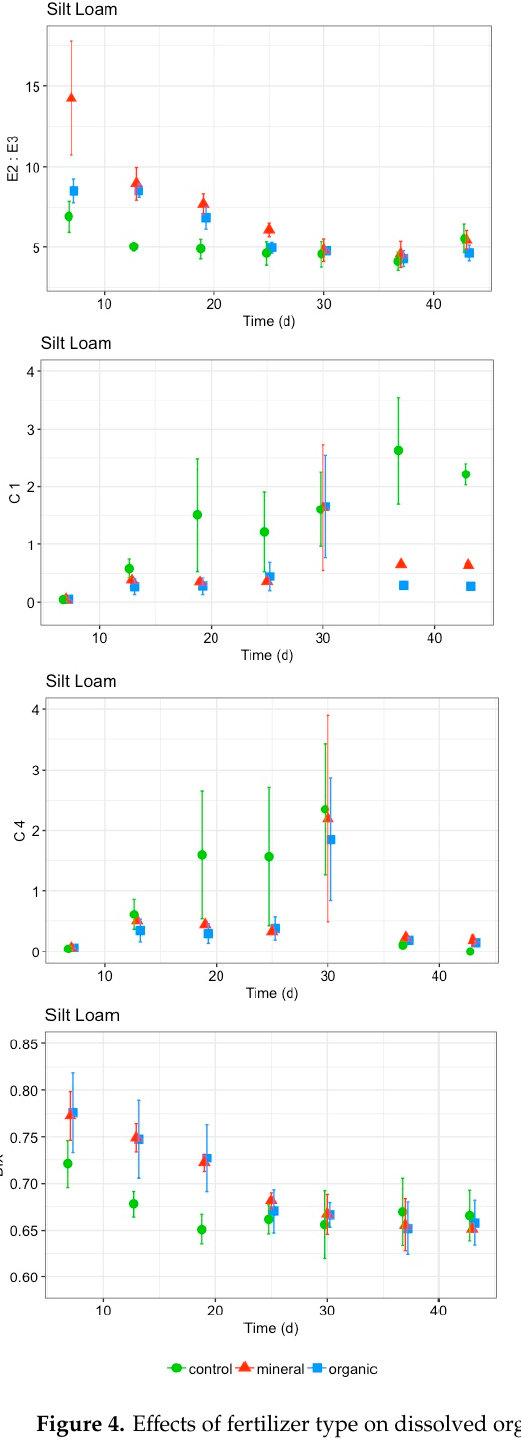
Figure 4. Effects of fertilizer type on dissolved organic matter (DOM) composition percolating through silt loam (left) and sandy loam (right). Mean (±SD) values of indices describing the size of the molecule (E2:E3; first line), humic-like component (C1; second line), protein-like component (C5, third line) and the degree of microbial activity (BIX; last line) over time are displayed (silty loam: n = 3; sandy loam: n = 4).